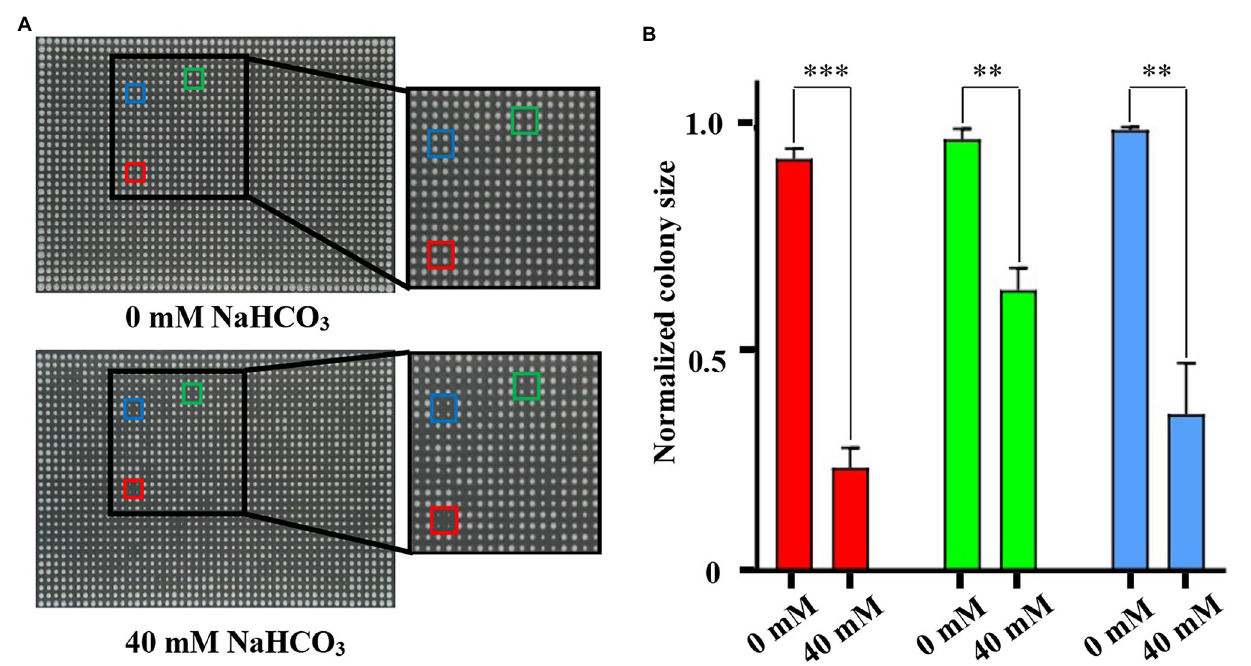
FIGURE 1 | Identification of appropriate NaHCO 3 concentration for genome-wide screening using plate SGA-V2-2. (A) The different colored boxes frame the growth of the same mutant on 0 and 40 mM NaHCO 3 , respectively. (Red: rvs161Δ ; Green: ste50Δ ; and Blue: pho2Δ ). Compared with the control, the same strains in the experimental group of 40 mM NaHCO 3 showed obvious growth defects. (B) The colony sizes of the framed strains in (A) were analyzed. Error bars indicate standard error. ** p < 0.01; *** p < 0.001; Student’s t